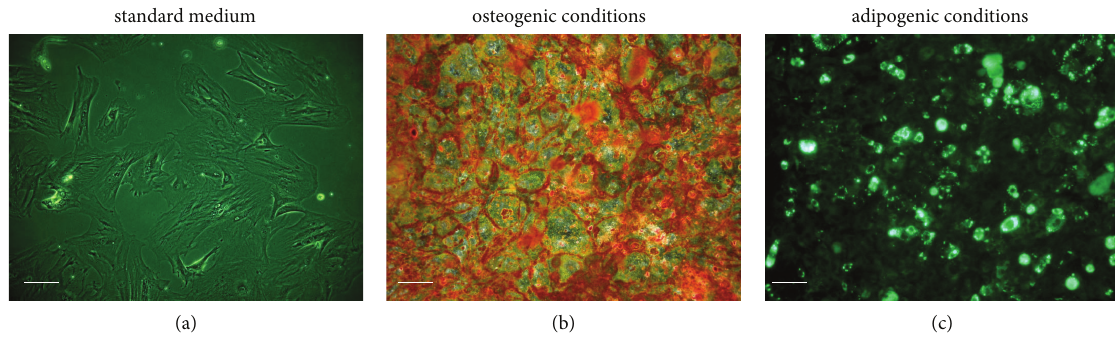
Figure 2: The morphology of adipose-derived mesenchymal stem cells isolated from subcutaneous fat tissue of mice in standard (a), osteogenic (b) and adipogenic culture (c). The calcium deposits formed in extracellular matrix of osteogenic culture were stained using Alizarin Red. The lipid-rich cellular organelles formed after adipogenic stimulation are visible as green droplets. Images included in the graph were chosen as representative. Both control and experimental cultures were carried out in triplicate. Magnification used is 100x. Scale bar is 200 𝜇 m.